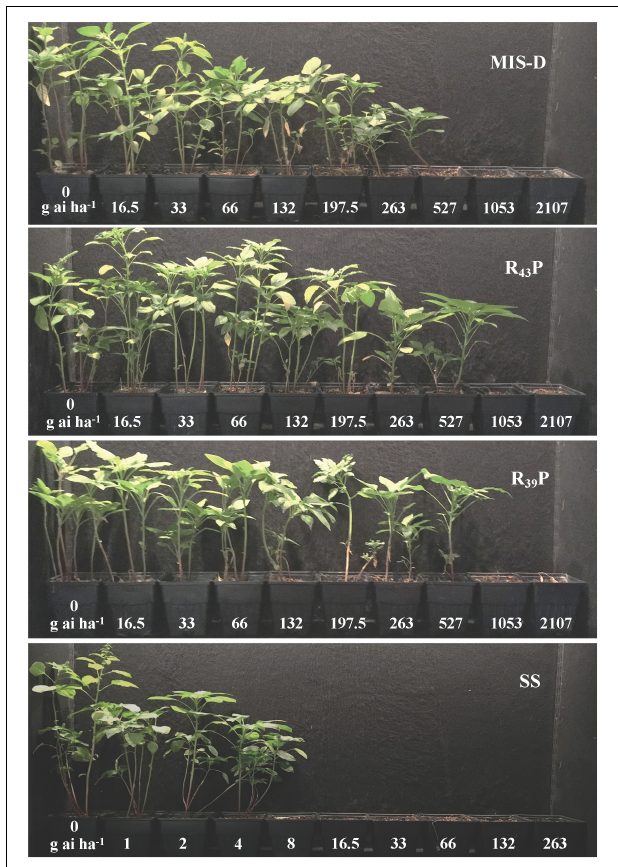
FIGURE 3 | PPO-resistant and PPO-susceptible Palmer amaranth populations in a greenhouse dose-response experiment. Resistant (MIS-D, R 39 P, and R 43 P) and susceptible (SS) A . palmeri plants after 21 days of being sprayed with 9 doses of fomesafen. The first pot to the left of each photo was non-treated; fomesafen doses were in g ai ha − 1